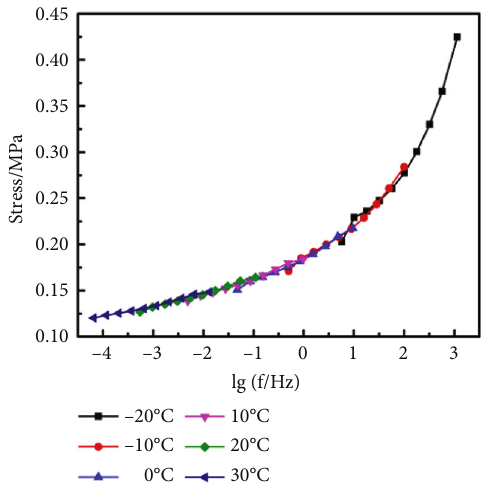
Figure 6: The curves at di ff erent temperatures in the master curve of stress logarithmic change with frequency are well